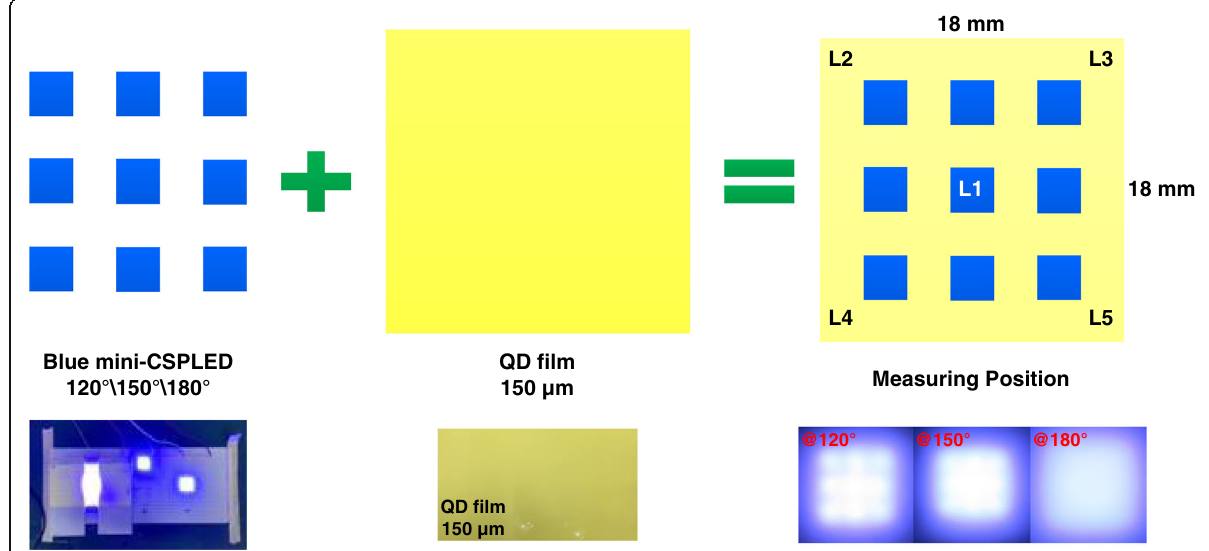
Fig. 3 Schematic diagrams of the brightness uniformity measurement